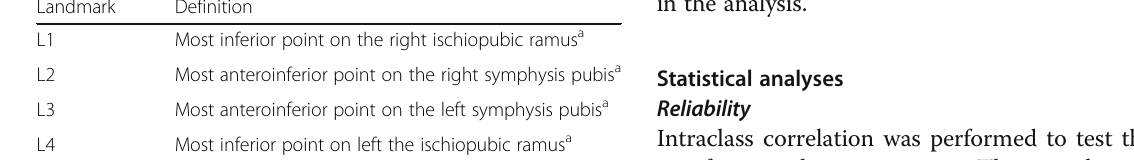
Table 1 Definitions of landmarks in Method 1 (Checkpoint) Landmark